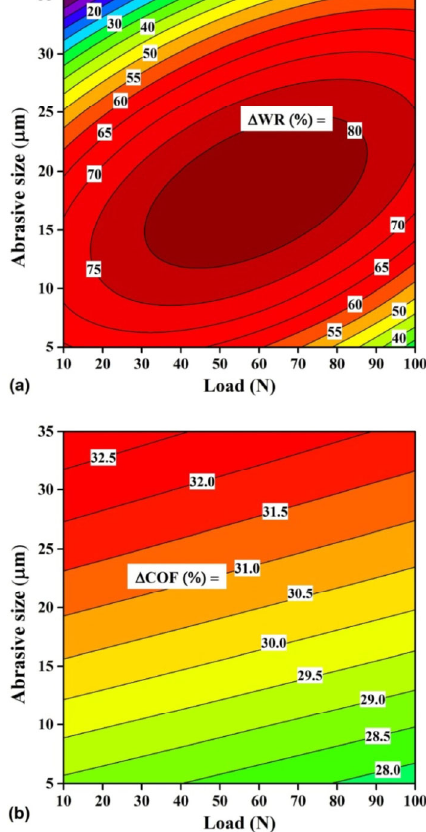
Fig. 10 Surface plots for the ∆ COF with respect to (a) abrasive size ( μ m) and load (N), (b) sliding distance (m) and load (N), (c) abrasive size ( μ m) and sliding distance (m), (d) sliding velocity (m·s − 1 ) and load (N), (e) abrasive size ( μ m) and sliding velocity (m·s − 1 ), and (f) sliding distance (m) and sliding velocity (m·s − 1 ). ∆ COF depicts percentage variation in coefficients of friction between alloy and composite.